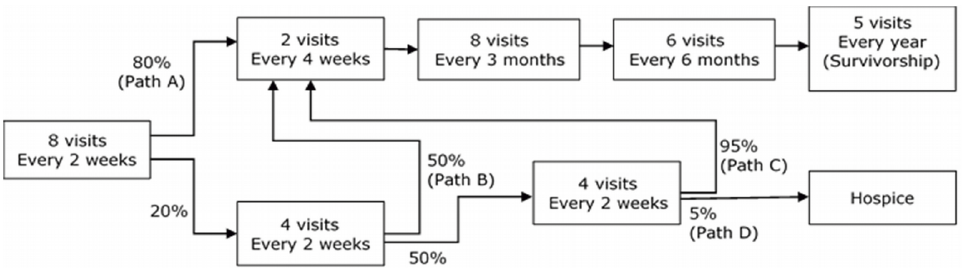
Figure 3. A sample treatment plan